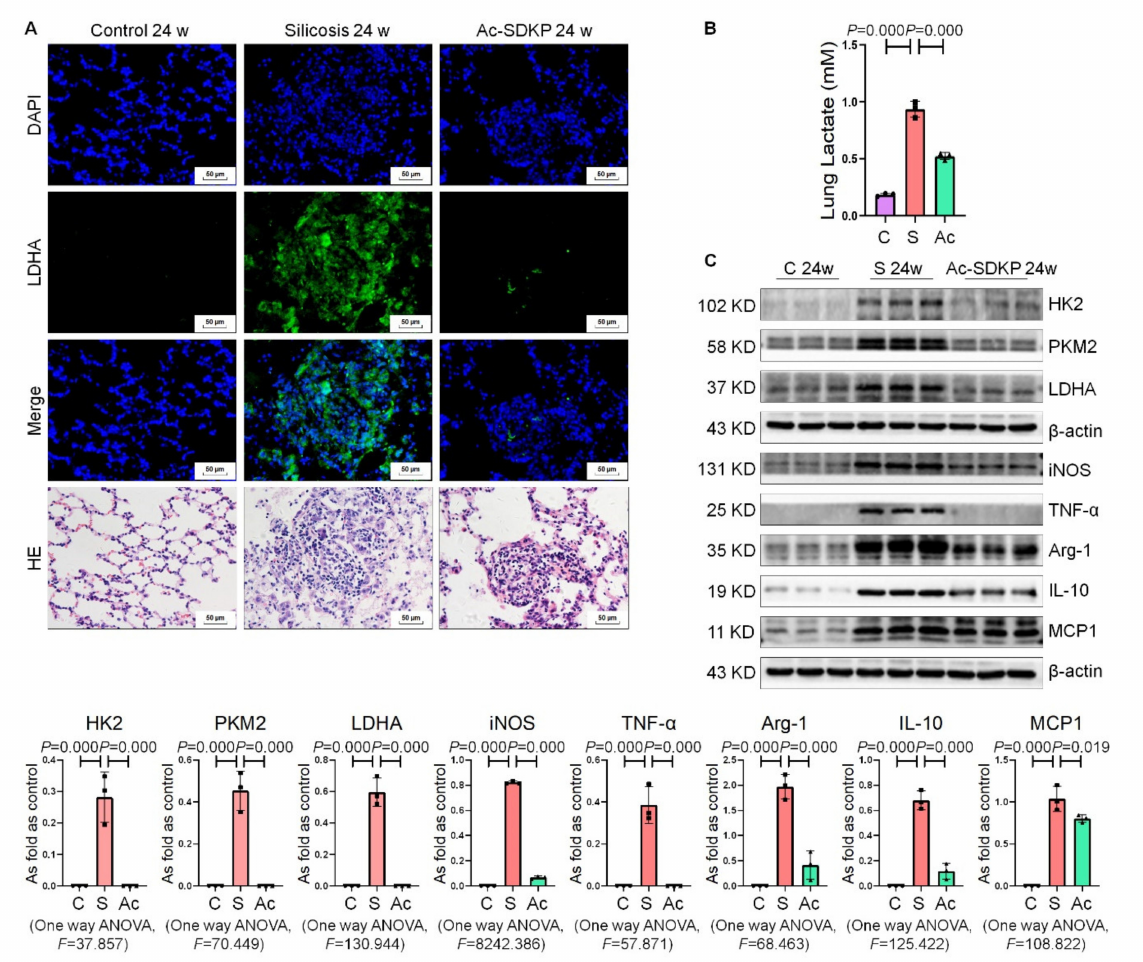
Figure 7. Ac-SDKP attenuates high glycolytic activity and macrophage activation in rats exposed to silica. ( A ) The expression of LDHA in rats exposed to silica was measured by IF staining, bar = 50 µ m. ( B ) The lactate content in rat lung tissue was detected using a lactate assay kit. ( C ) Levels of HK2, PKM2, LDHA, iNOS, TNF- α , Arg-1, IL-10, and MCP1 in silicotic rats were measured by Western blotting. Data are presented as the mean ± SD. n = 3 per group. C: control 24 w; S: silicosis 24 w; Ac: Ac-SDKP treatment 24